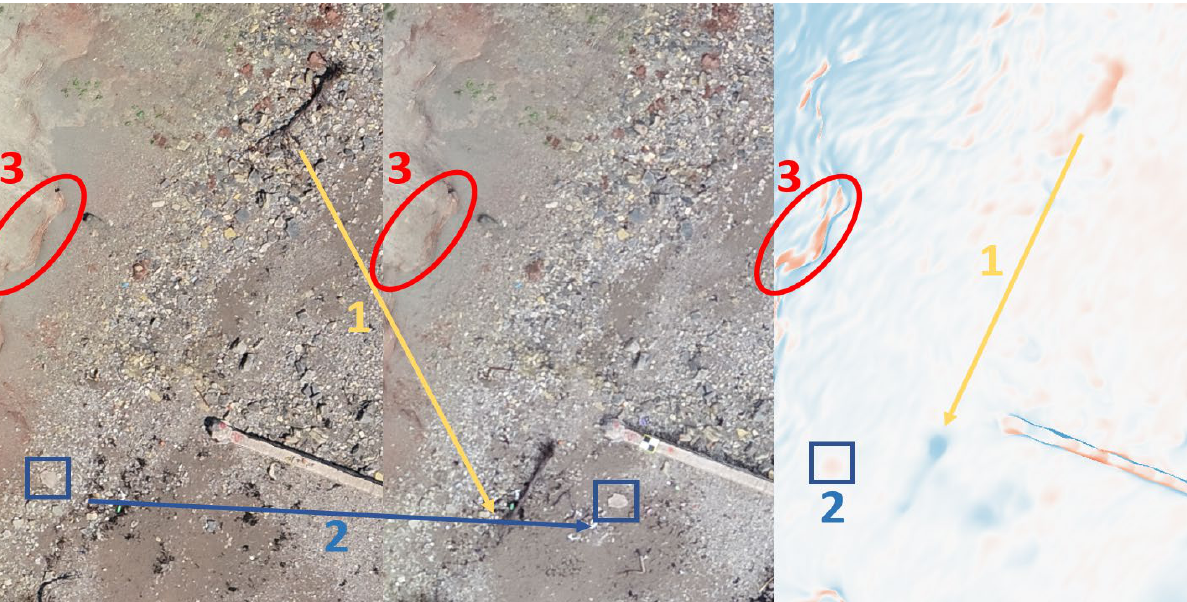
Figure 18 - Zoomed Section of the Beach Near to the Cliff Face Highlighting the Movement of the Tree Trunk (1); the movement of a slab of rock (2) which is identified as a loss (slight pink) in the difference map; and some displacement of the very fine stones/scree at the base of the cliff (3). (Left: Survey 1; Middle: Survey 2: Right: Difference